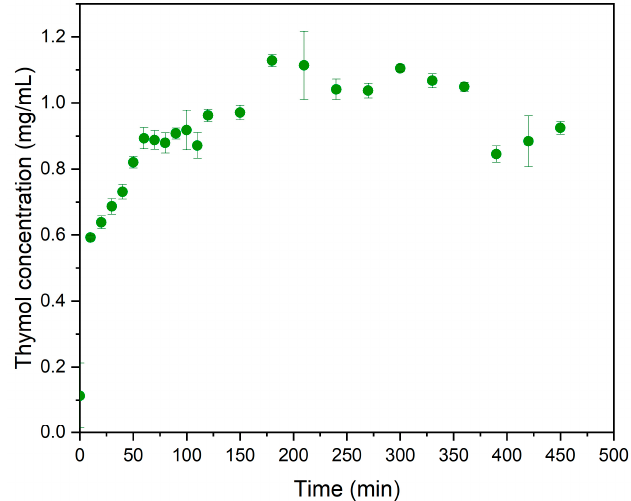
Figure 3. Thymol liberation from zinc hydroxide salt in PBS at 25 °C.